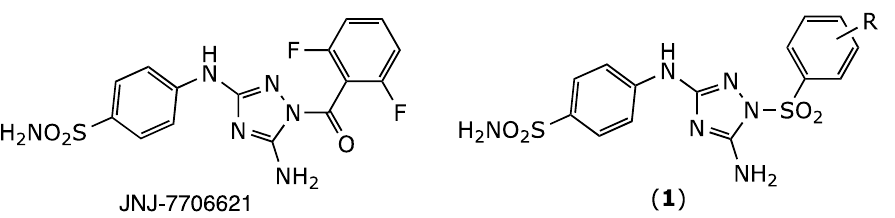
Figure 1 . Chemical structure of JNJ-7706621 and its designed bioisosteric analogues ( 1